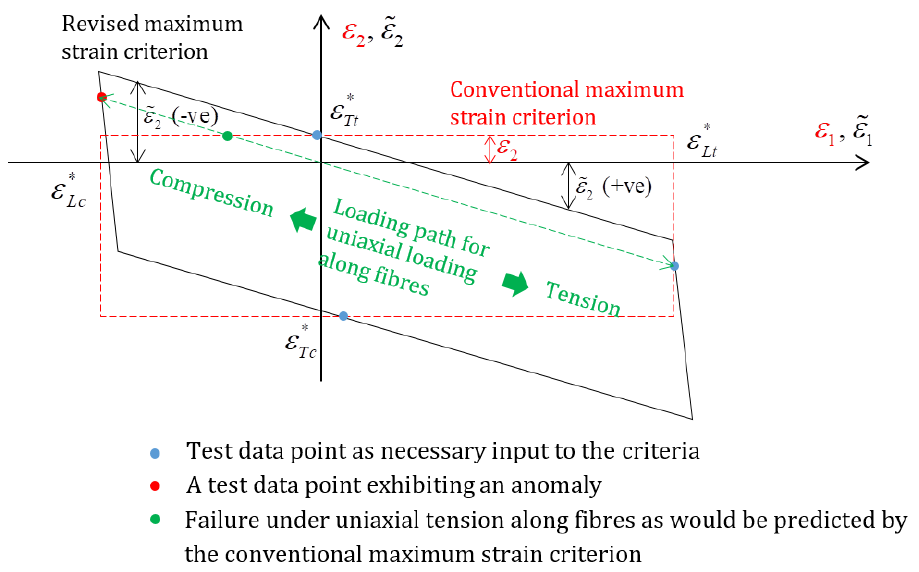
Figure 2. Failure envelopes from the conventional maximum strain criterion and the unified one.